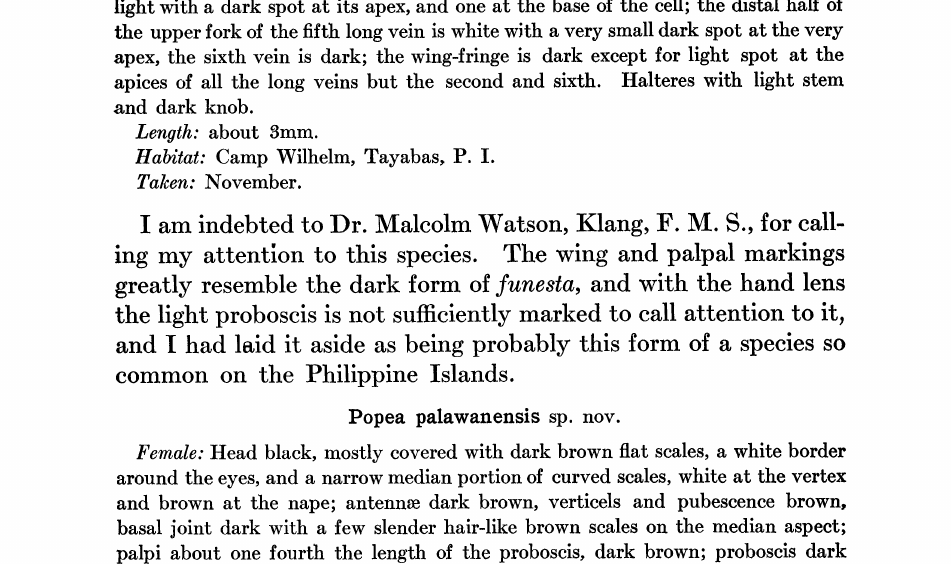
Female: Head black, mostly covered with dark brown fiat scales, a white border around the eyes, and a narrow median portion of curved scales, white at the vertex and brown at the nape; antennm dark brown, verticels and pubescence brown, basal joint dark with a few slender hair-like brown scales on the median aspect; palpi about one fourth the length of the proboscis, dark brown; proboscis dark brown, eyes dark brown; clypeus bro.wn. Thorax dark; prothoracic lobes heavily covered with white fiat scales and dark brown chmte; mesonotum dark brown with silvery white slender curved scales very closely set to form a white spot covering the cephalic third, the caudad edge is irregular, and reminds one of the "solid W" described for Lepidotomyia magna Theo; the remainder of the mesonotum covered with slender curved, rich, dark brown scales, except an irregular white spot just cephalad of the wing joint, and white scales forming a line around and extending on the "bare space"; Scutellum dark, partly denuded, the mid-lobe having a few white fiat scales in the median line, a few white rather broad curved scales laterad of the fiat ones, and then brown curved scales. The lateral lobes are denuded, except for one white and a few brown curved scales. There have apparently been five marginal chete on the mid and three on the lateral lobes; pleura dark brown with five or six large bunches of silvery white fiat scales; metanotum dark. Abdomen covered with dark brown scales except for rather heavy basal lateral brilliant white spots. On the venter are also heavy basal brilliant white spots sometimes extending as basal white bands, and there are on several segments, bunches of very long brown scales, so much constricted on the basal part as to appear almost petioled. Legs brown; coxm and trochanters testaceous with a few white scales; the fore femora white on the ventral aspect nearly, to the apex, fore tibia brown only on the dorsal aspect, the ventral and lateral aspects brilliantly yellowish white; all the